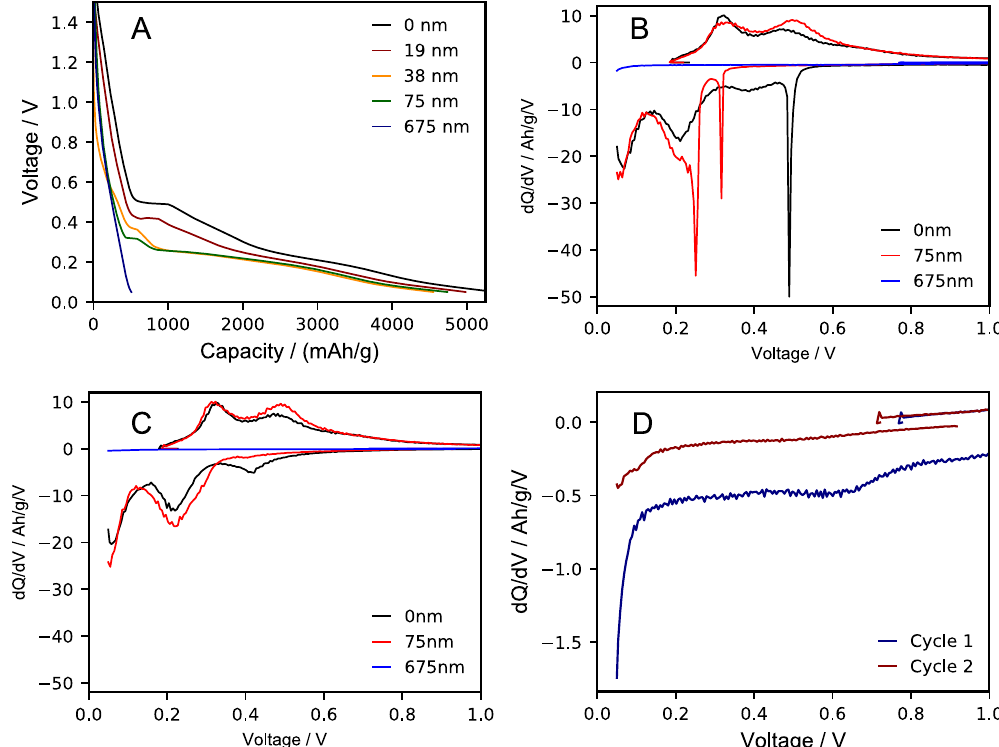
Figure 4. ( A ) First lithiation voltage profiles as a function of polymer coating thickness. Differential capacity curves during ( B ) the first cycle and ( C ) the second cycle of silicon coated with 0, 75 and 675 nm of PMMA, cycling at C/3. ( D ) Differential capacity curves during the first and second cycles of only the silicon electrodes coated with 675 nm of PMMA to highlight reduction peaks. All electrodes are cycled at of C/3 rate from 0.05 V to 1.5 V at room